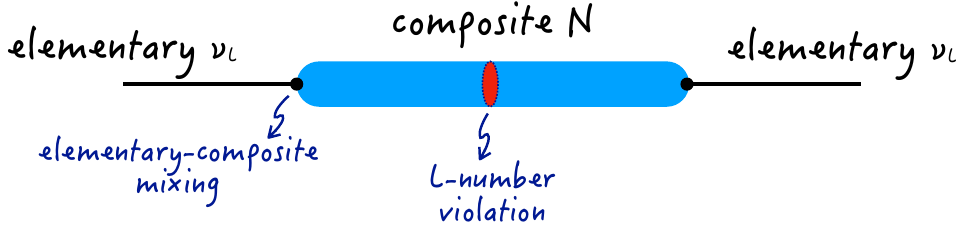
Figure 1 . A sketch of the generation of neutrino masses in our framework through partial compos- iteness. Elementary neutrinos mix with composite singlet neutrinos and lepton number is violated in the composite sector. The light neutrino mass may be explained either by small mixing between the elementary and composite neutrinos, or by small lepton number violation in the composite sector, with a continuum of possibilities in